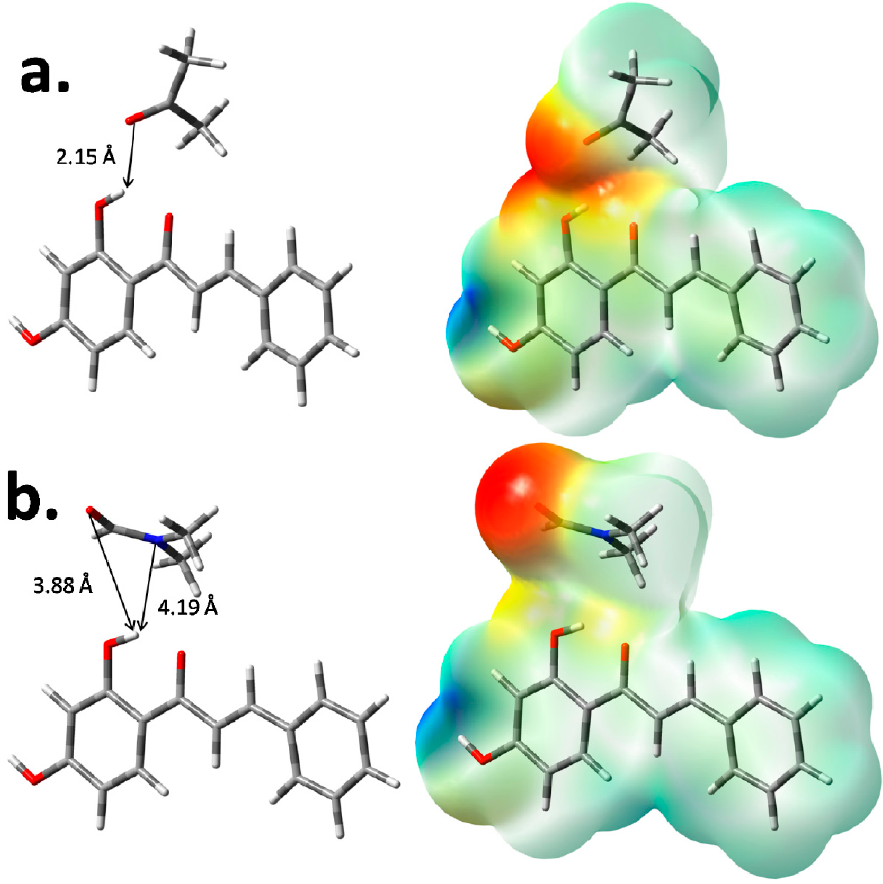
Figure 1. Density functional theory (DFT) results with H-bond and electrostatic potential map (ESP) of 1 with ( a ) acetone and ( b ) DMF.